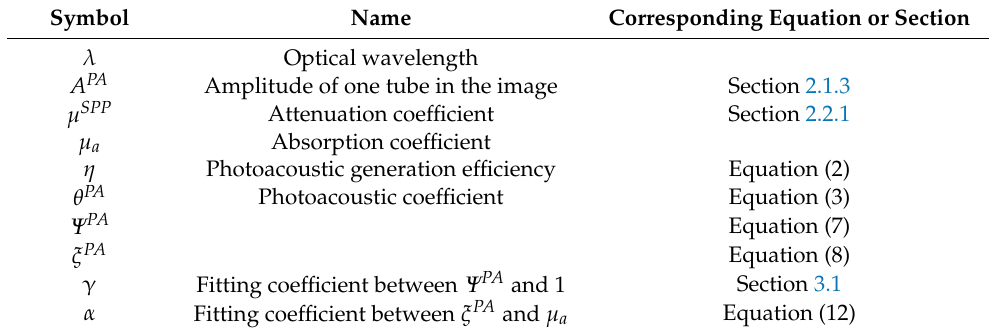
Figure 2. Diagram summarizing the computed quantities and their relationship to the measurements performed with the calibration solution and the sample solution. The symbols are listed in Table 1. Table 1. List of